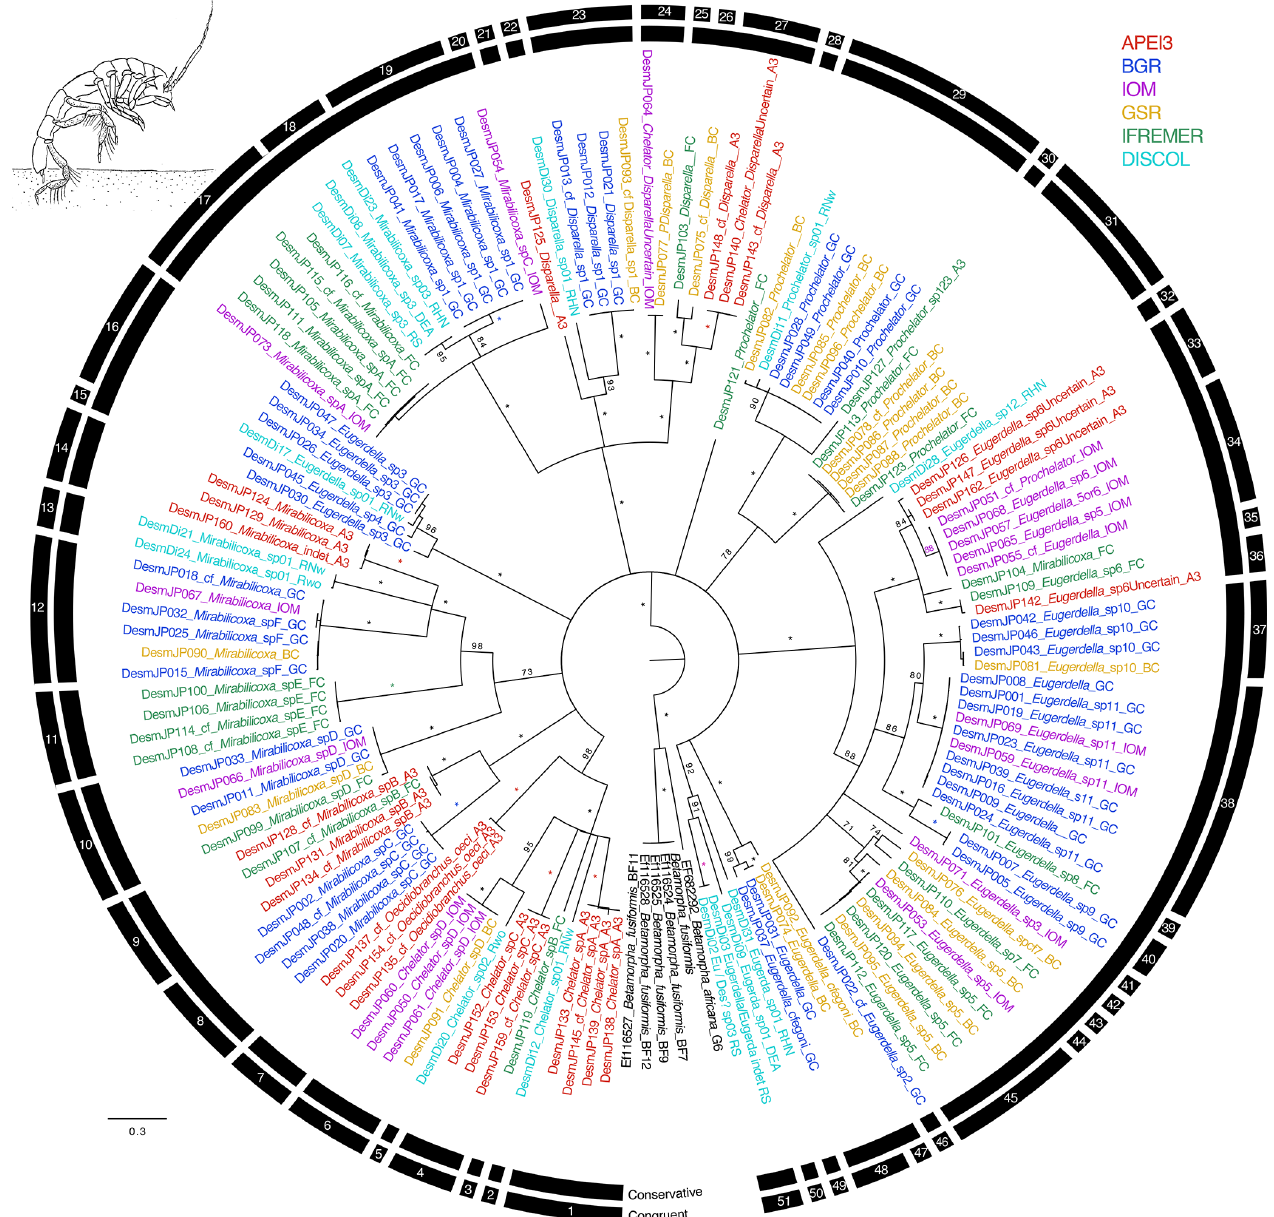
Figure 4. Phylogenetic tree of all desmosomatid samples based on 16S and COI sequences for 143 specimens. Colors indicate collection lo- cation with black indicating outgroups. All unsupported branches were collapsed, and bootstrap support is indicated with asterisks indicating 100% bootstrap support. The outer two bars summarize the results of the species delimitation analyses which included morphological deter- mination, VSEARCH for individual genes, ABGD for individual genes, and PTP and mPTP for both individual genes and the concatenated datasets. The conservative bar indicates that all SD analyses supported that split, while the congruent bar indicates that the majority of SD analyses showed that split. Numbers on congruent bars are arbitrary and are provided to allow a way to refer to specific supported